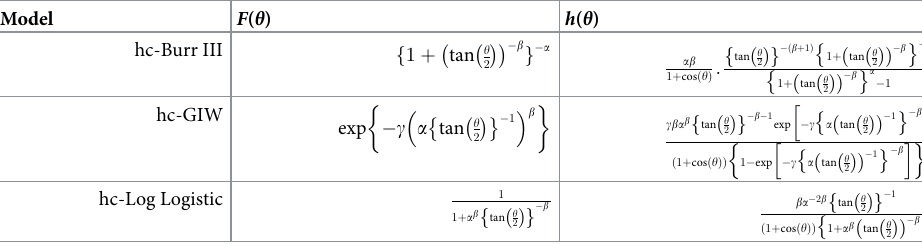
Table 1. Cdfs and hazard functions of the sub models of hcMB − III